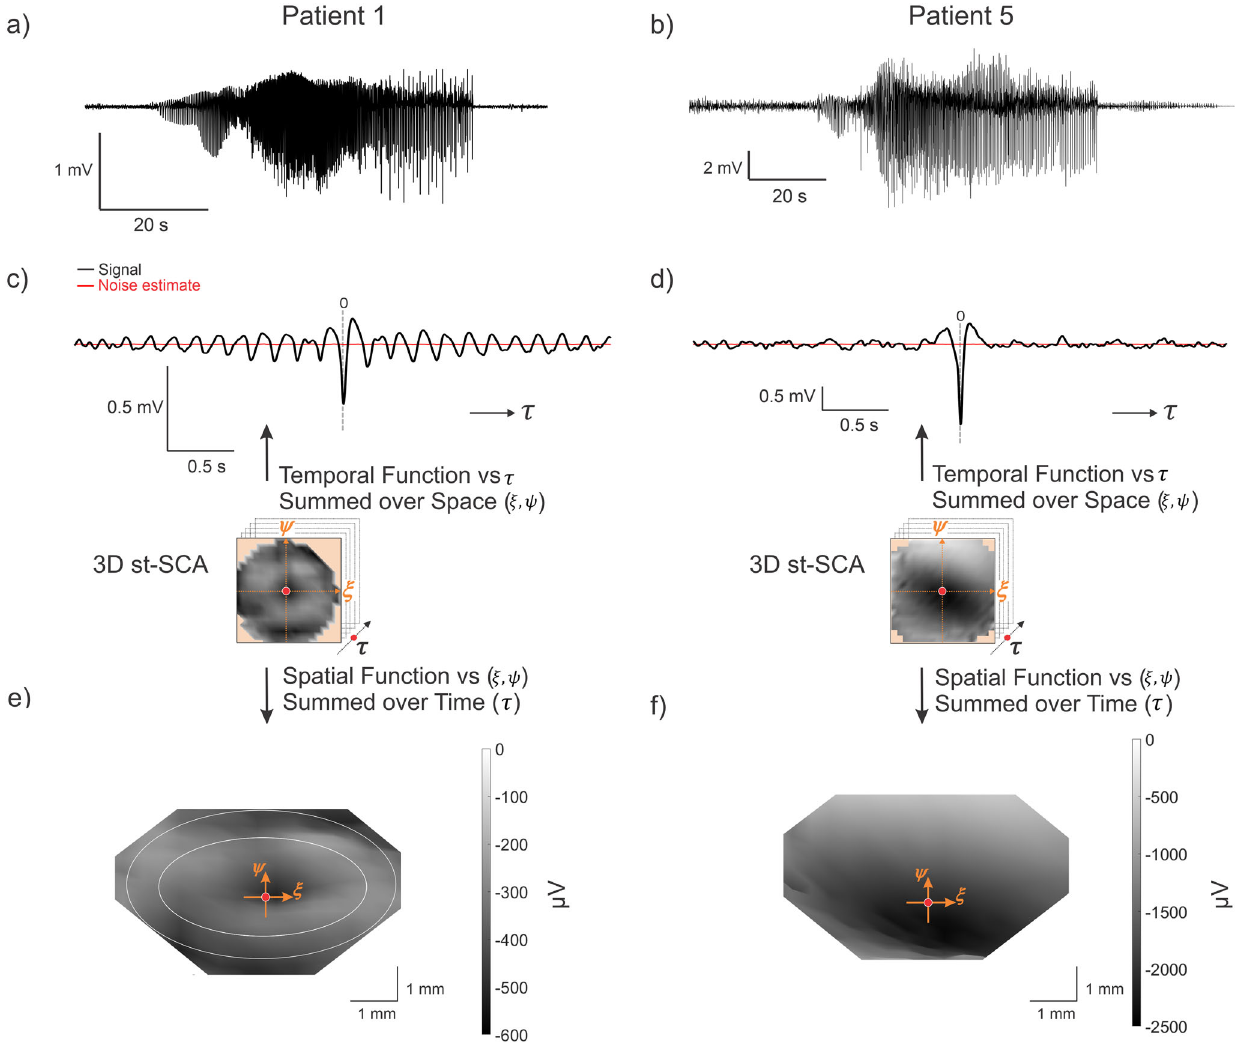
Fig. 4 Properties of the ictal spatiotemporal spike-centered average (st-SCA) function during a focal seizure show different patterns for two representative patients with the MEA positioned in recruited territory. a , b Representative traces of the average LFP activity across the microelectrode array for Patient 1 and Patient 5. c , d The temporal average (black trace) is calculated by averaging the st-SCA over all spatial contributions (±3.6 mm). Noise estimates are shown in red. e , f A 3D view (azimuth = 0°, elevation = 70°) of the 3D st-SCA summed over time τ = ±35 ms. The center ð ξ ; ψ ¼ 0 ; 0 Þ is indicated by the red dot. The two concentric circles in ( e ) are drawn to indicate that the center is surrounded by two rings. Note the apparent radial symmetry of the st-SCA pattern in Patient 1. The ξ -axis and ψ -axis represent the spatial dimensions of the MEA, and the third dimension ( z -axis) in this topological view represents microvolt ( μ V) units. The grayscale corresponds to the z -axis and is in μ V